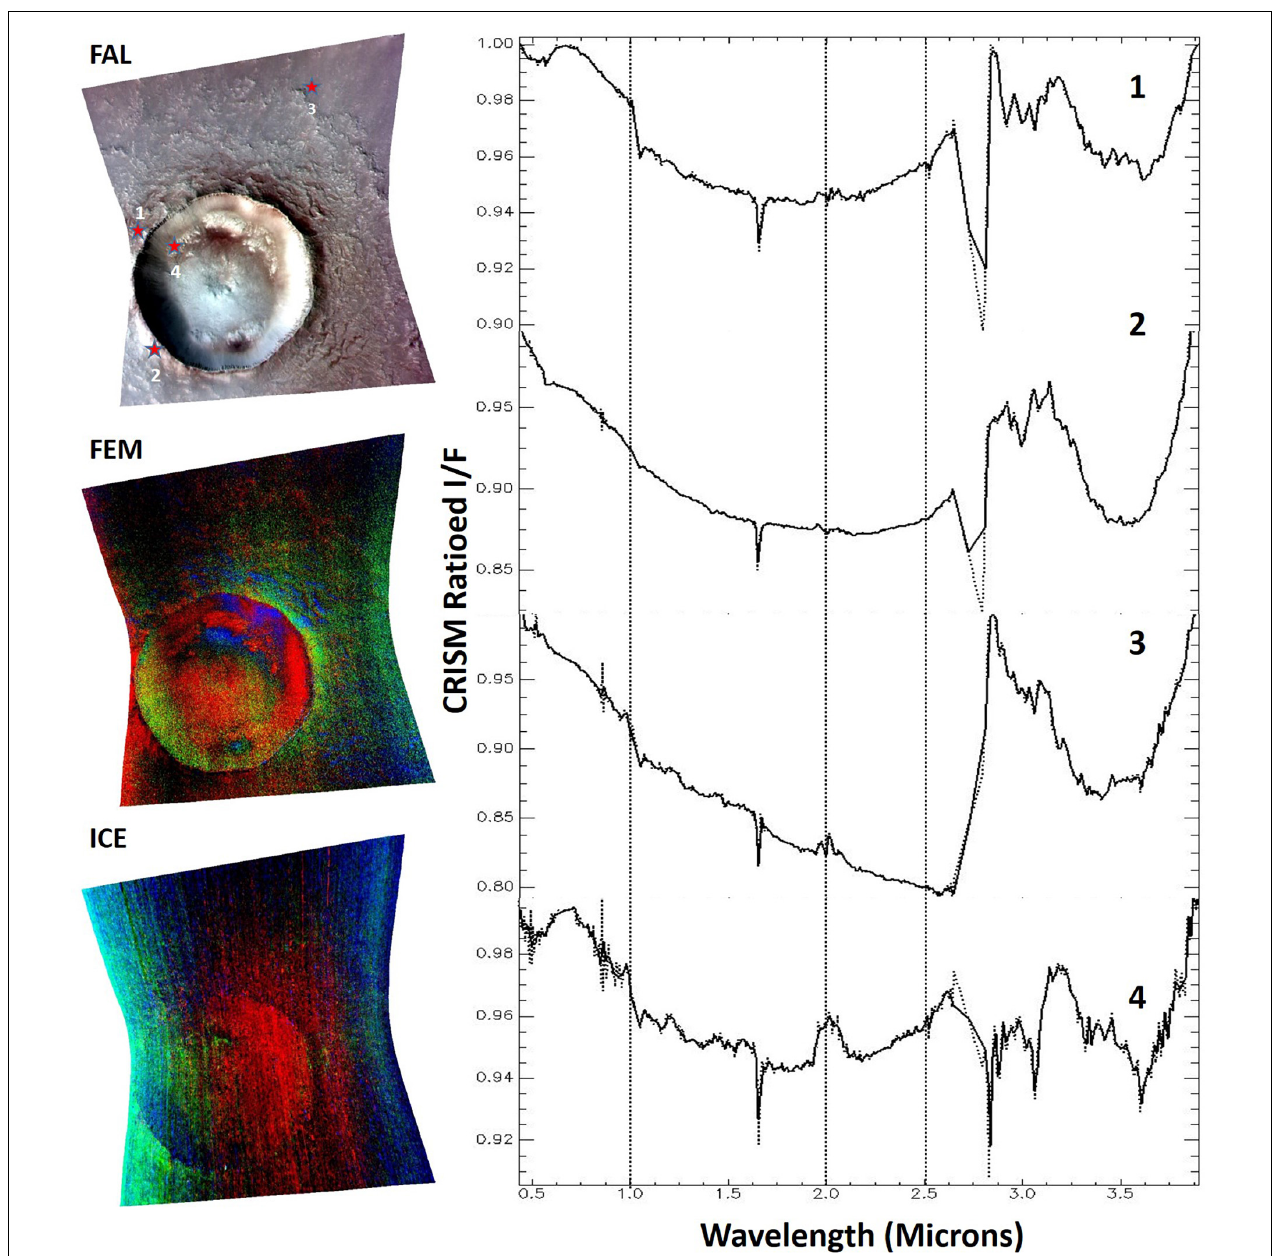
FIGURE 10 | FAL, FEM, and ICE browse products derived from CRISM data to correlate the map to the surface feature and to assess information regarding ferric and ferrous minerals, water, or carbon dioxide frost or ice. Sample locations are representatively marked in the FAL browse product along with the extracted spectra in Hesperian unit Unnamed crater